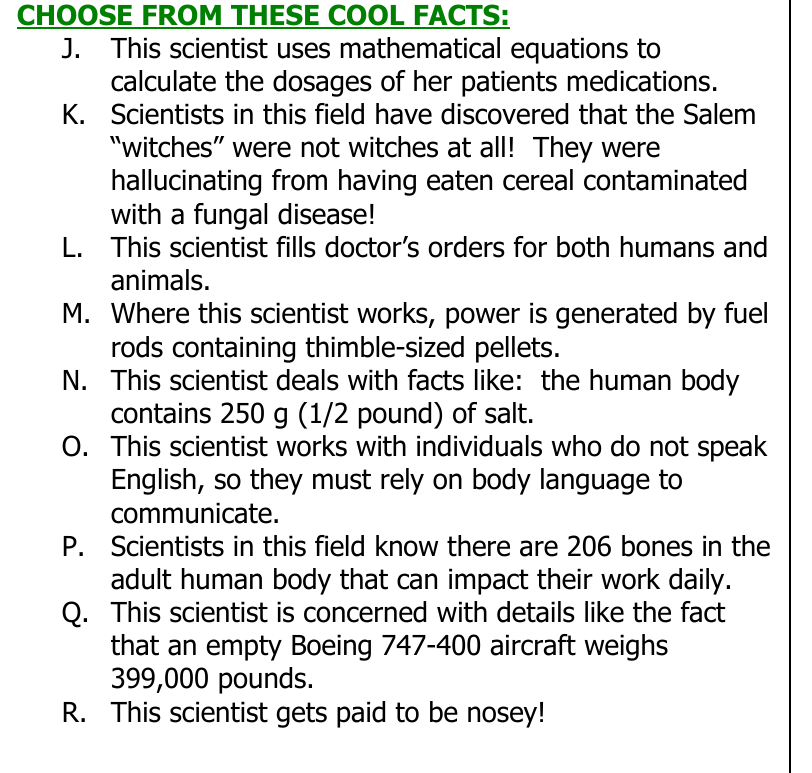
4. Answer one of the following multiple choice questions as it relates to your breakout session workshop. Circle the correct answer to the